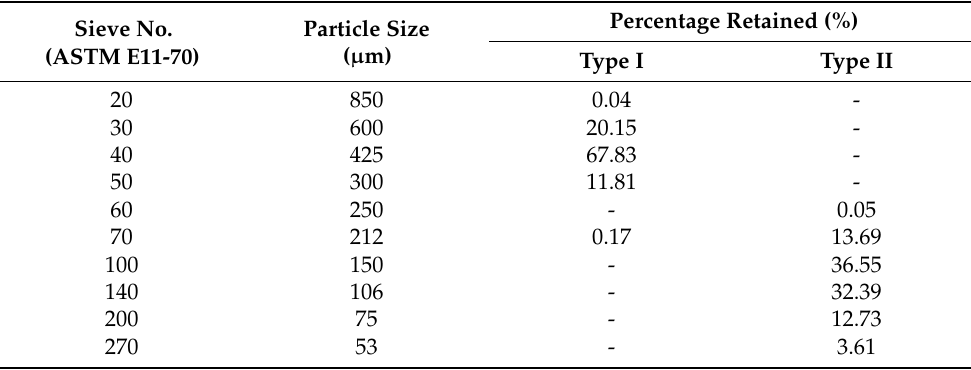
Table 3. The particle size distribution of the fine aggregates.